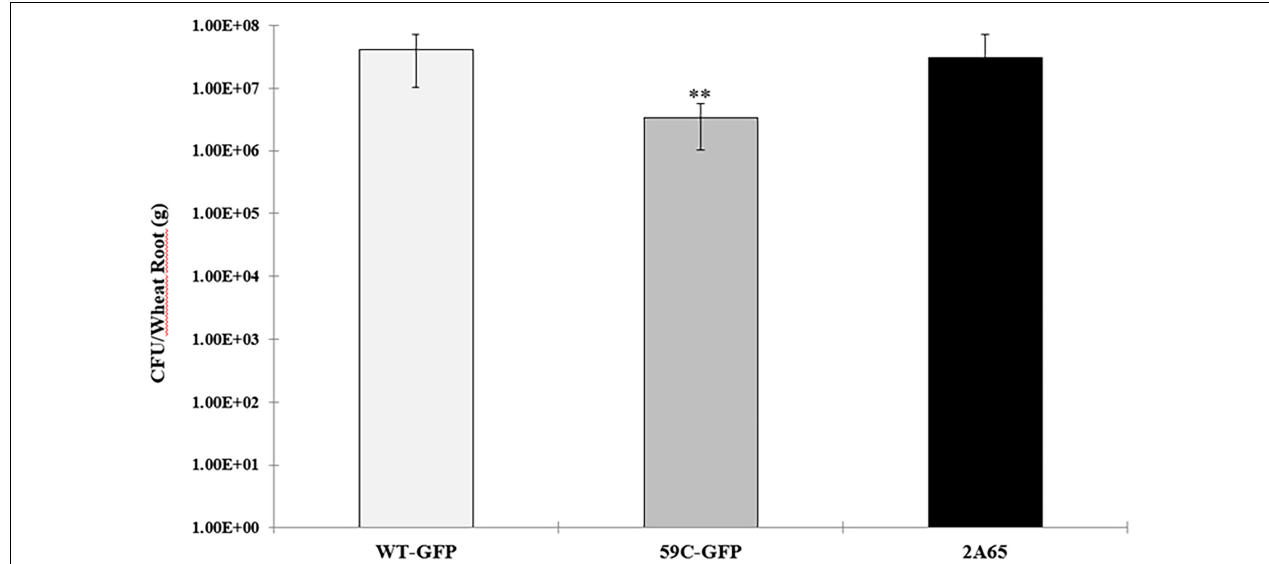
FIGURE 7 | Endophytic colonization of A. baldaniorum and derivative strains: A. baldaniorum –GFP-Gm R , WT strain, A. baldaniorum 59C-GFP-Gm R , mutant strain, and A. baldaniorum 2A65-GFP-Gm R , Km R , complemented strain. Bar plots representing the mean and standard error of colony-forming units recovered per gram of wheat root after surface-sterilization (endophytic bacteria). The data was obtained from three independent experiments. The mean of WT and the 59C mutant strain assay was compared with a Student’s t -test and was significantly different with a P -value = 0.004011 and indicated with asterisks.